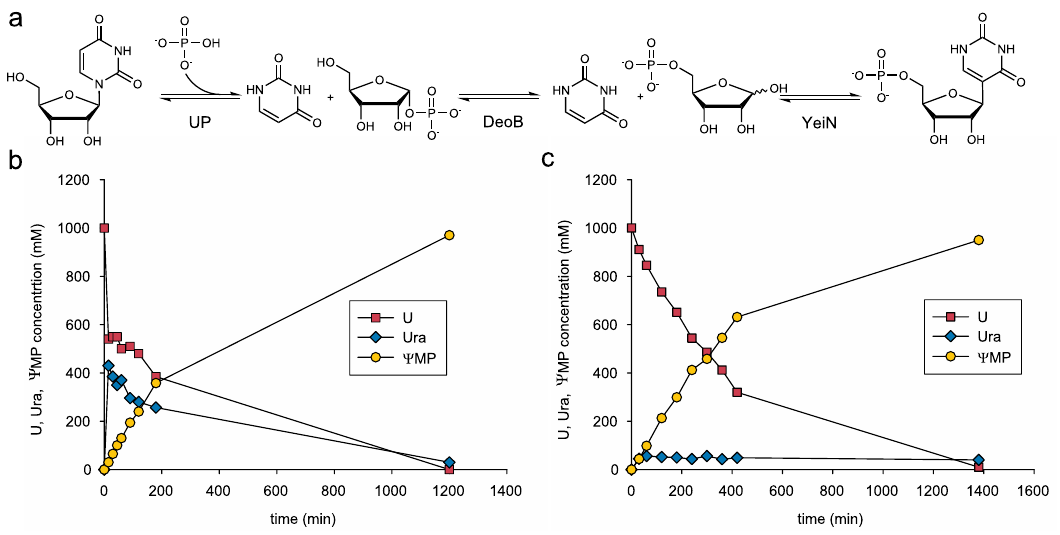
Fig. 3 | Three-enzyme cascade synthesis of Ψ MP. a Scheme of the enzymatic cascade towards Ψ MP. b Reaction time course of Ψ MP synthesis at 100 µ L (25mg) scale. Here, 1.5M potassium phosphate buffer pH 7.0, 1.0M U , 10mM MnCl 2 , 0.1mM Glc1,6diP, 1mg/mL UP, 10mg/mL DeoB and 6mg/mL YeiN were incubated